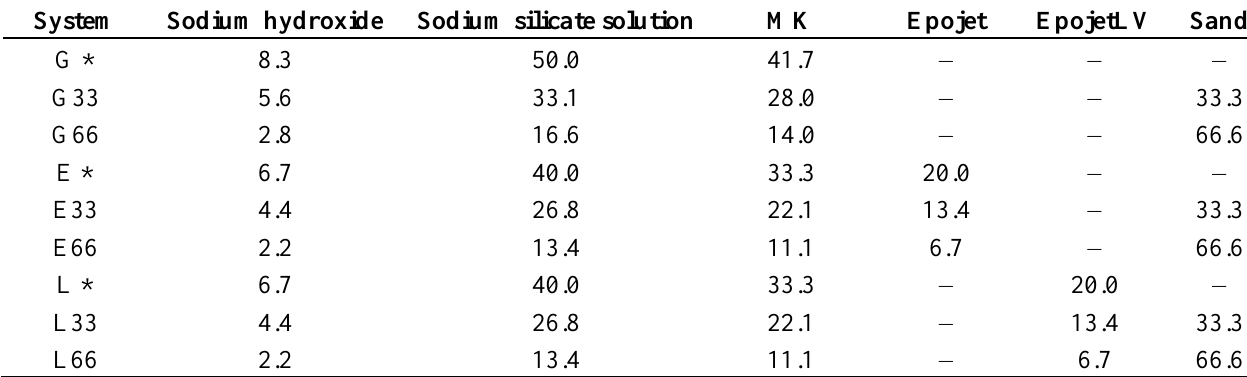
Table 4. Mix design proportion (%